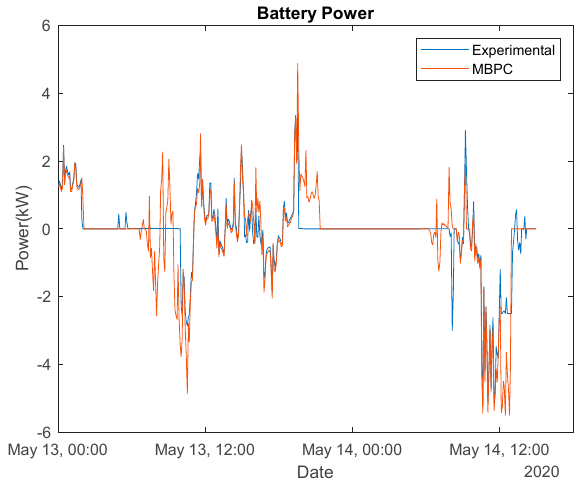
Figure 13. Battery power evolution (cloudy day). Consequently, the BSC is higher in the case of MBPC, while it is exhausted during several periods of the 13 May (Figure